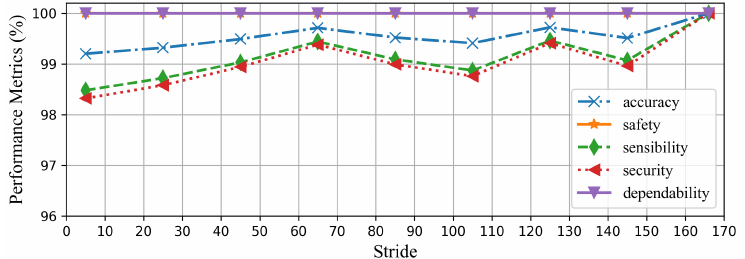
Figure 9. Impact of the sliding window stride on the performance metrics of the CAE-HIFD. The CAE-HIFD prevents false detection of disturbances as HIFs using kurtosis value.